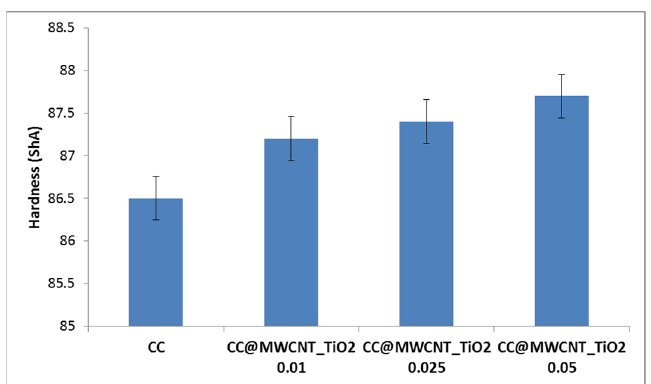
Figure 8. Hardness of the obtained films.